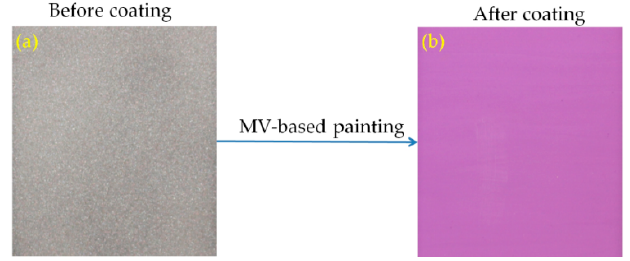
Figure 2. Steel plate specimens before ( a ) and after ( b ) coating.